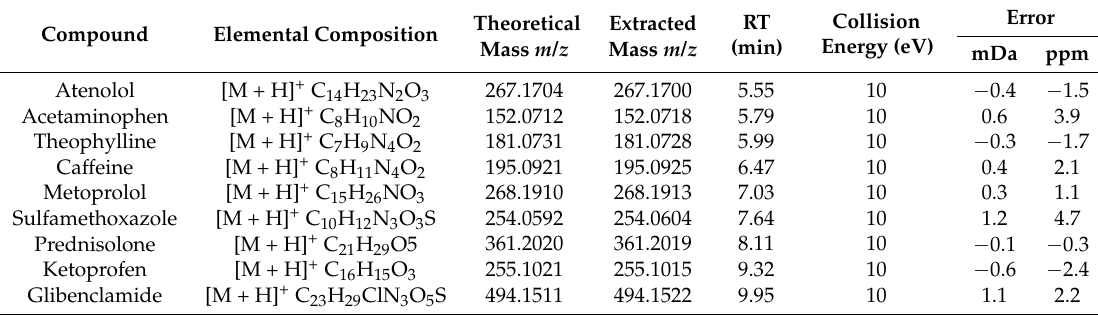
Table 2. Retention times and accurate mass measurements of molecular ions of target pharmaceuticals in a standard solution.